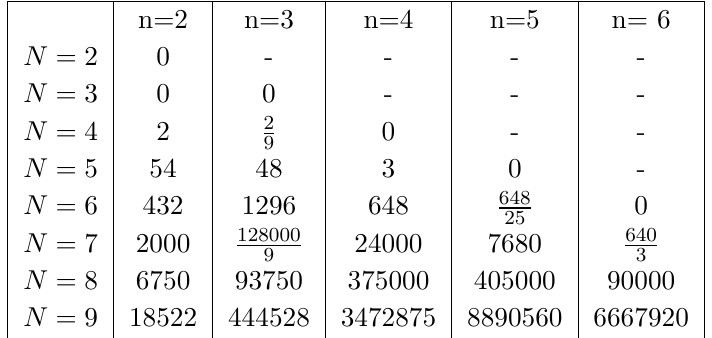
[ n ] ; [ n (cid:0) 1 ; 1] ; [ n (cid:0) 1 ; 1]